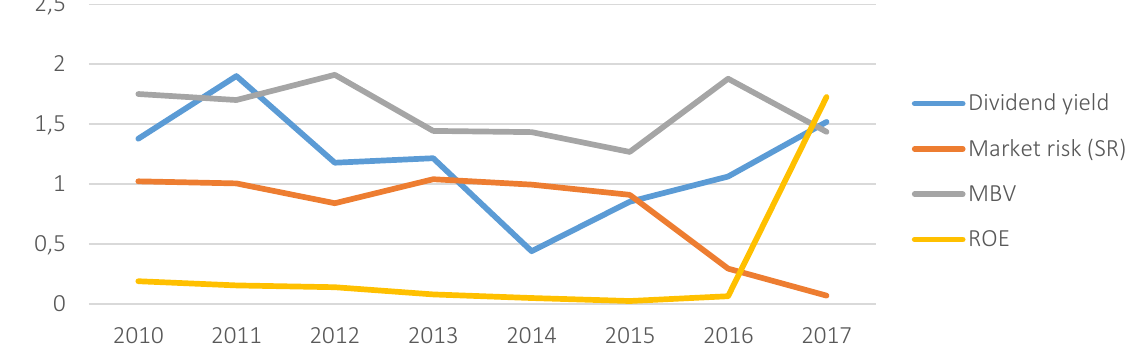
Figure 3. Mean (A2) of dividend yield, stock beta, MBV, and ROE